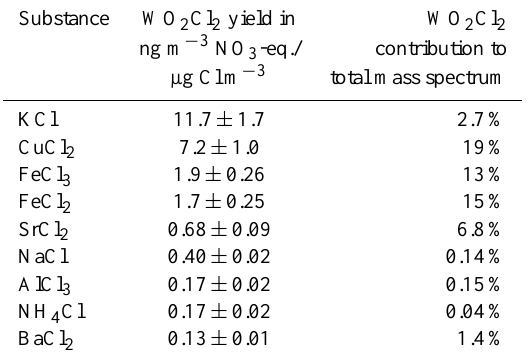
Table 4. WO 2 Cl 2 generation yields (and standard deviations) and fractional contribution to the total mass spectrum for the measure- ment of various Cl-containing